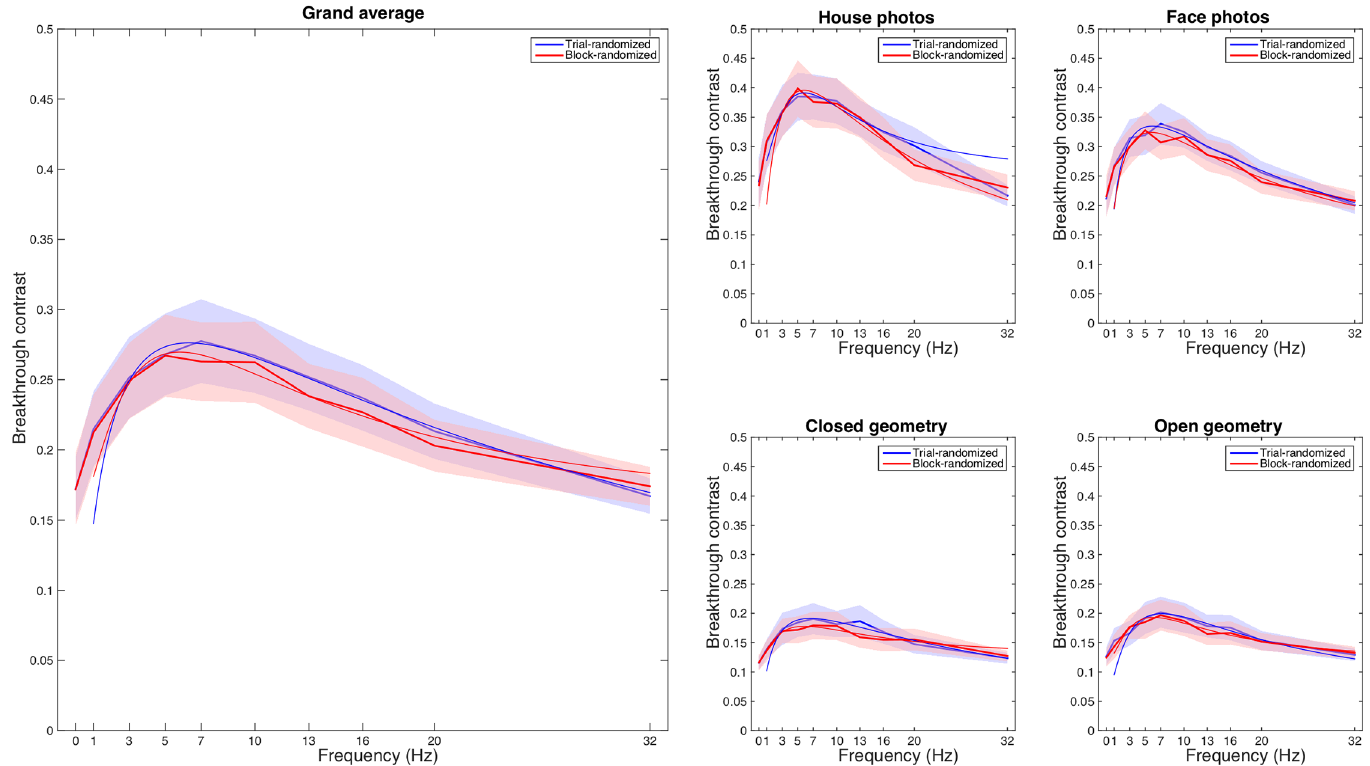
Fig 4. (a) Grand average and (b) different stimuli skewed-normal curves of breakthrough contrast on two randomization conditions: the bold curves represent the measured breakthrough contrast at given masking frequencies; the thin curves represent the result of fitting skewed-normal functions to the